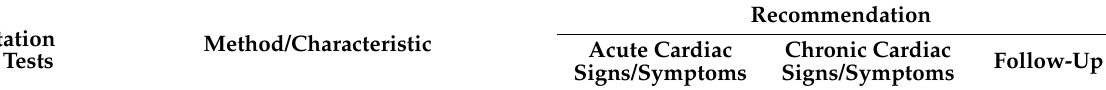
Table 2. Recommended diagnostic tests for the diagnosis of